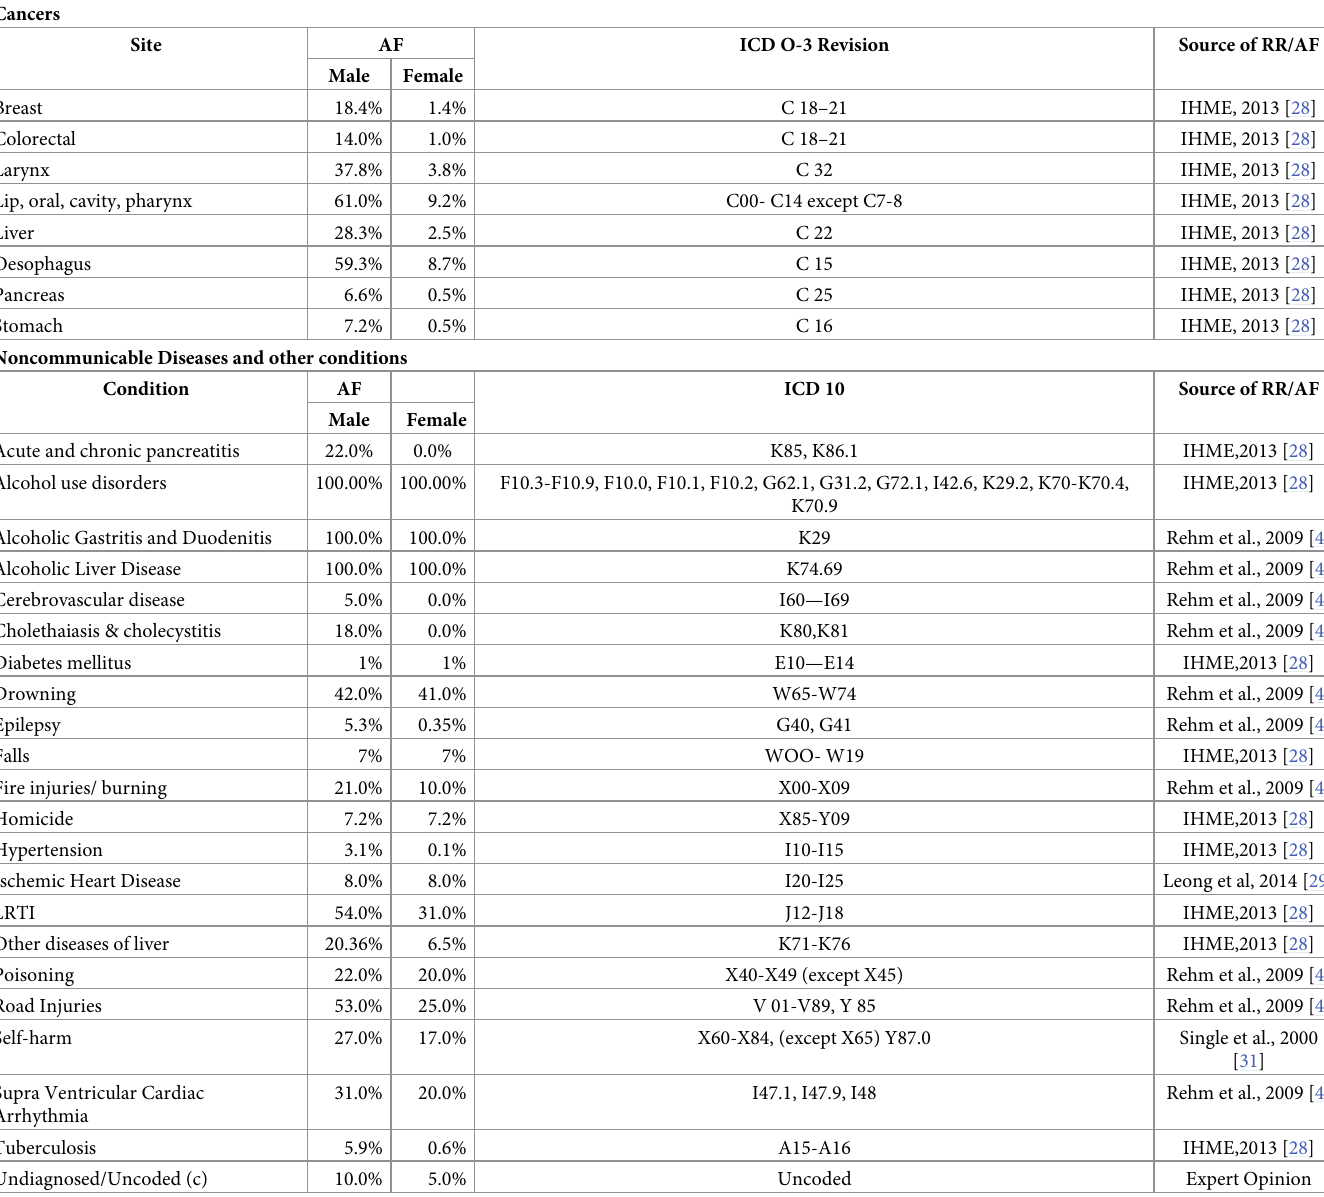
Table 2. Alcohol attributable fractions used for mortality due to